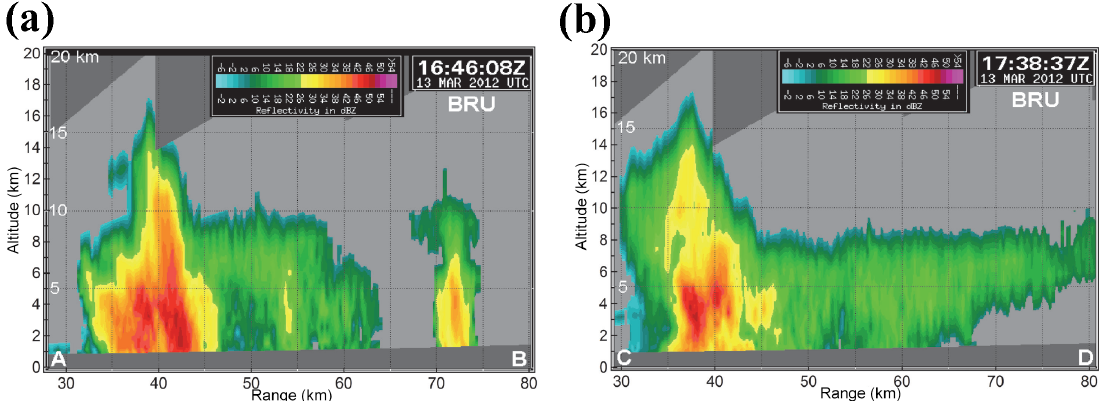
Figure 8. Vertical cross section of IPMet radar reflectivity on 13 March of (a) Cell 1 (16:46UTC, baseline A–B in Fig. 7a), (b) Cell 2 (17:38UTC, baseline C–D in Fig. 7b). Dark grey shading in the top of the plots corresponds to the areas without radar PPI overlapping